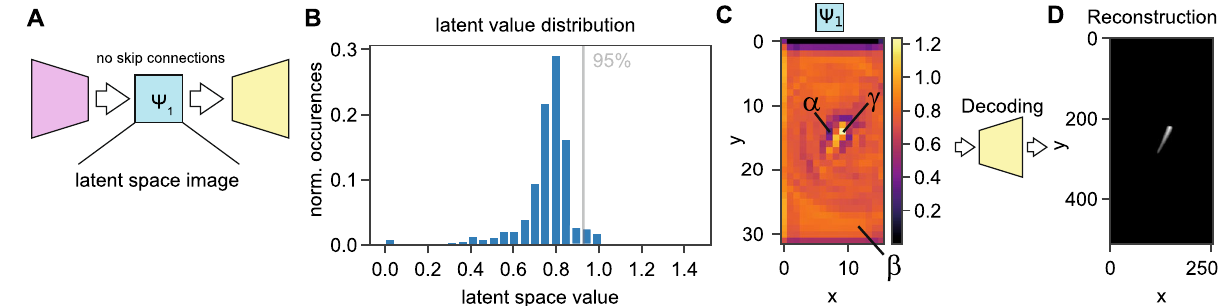
Figure 2. The latent space image (cid:31) 1 values provide interpretable context. ( A ) Deep neural network (DNN) used for further experiments. DNN consists only of a single latent space image (cid:31) 1 without skip connections. ( B ) Value distribution of the latent space image (cid:31) 1 across all pixels of all images in the BAGLS training dataset. We indicated the 95% confidence interval that is used for defining γ pixels. ( C ) The average latent space image (cid:31) 1 across 30 frames. We indicate the three pixel subtypes, α for glottis refining, β for background-defining, and γ for glottal area defining pixels. ( D ) The average reconstruction obtained from feeding (cid:31) 1 from panel C into the